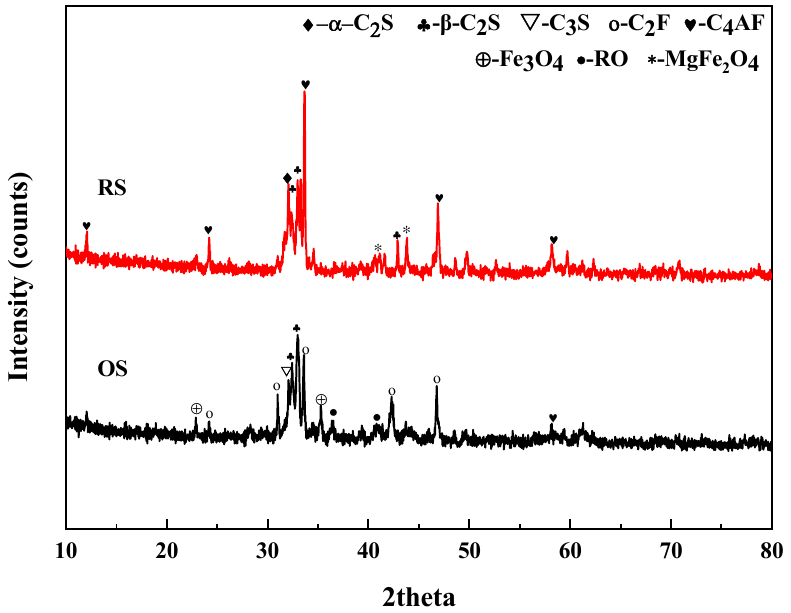
Figure 1. X-ray diffraction of BOF slag before and after reconstruction. Unmodified BOF slag and reconstructed BOF slag were ground for 10 min by vibrating mill, respectively, the SSA and particle distribution of BOF slag are tested, and the results are as follows. It can be seen from Figure 2. that the small-size particles in the BOF slag increase, while the large-size particles are less after high-temperature reconstruction. The average particle size of the BOF slag is reduced from 51.75 µ m to 39.96 µ m as plotted in Figure 2. Meanwhile, the SSA of the fine powders prepared by the reconstructed slag and the unmodified steel slag under the same grinding time was studied. It is found that the SSA of the reconstructed steel slag powder increased from 303.1 m 2 /kg of the unmodified steel slag to 354.5 m 2 /kg as shown in Table 3, which fully shows that the grindability of the reconstructed steel slag modified by the calcium-aluminum composition is better than that of the unmodified converter steel